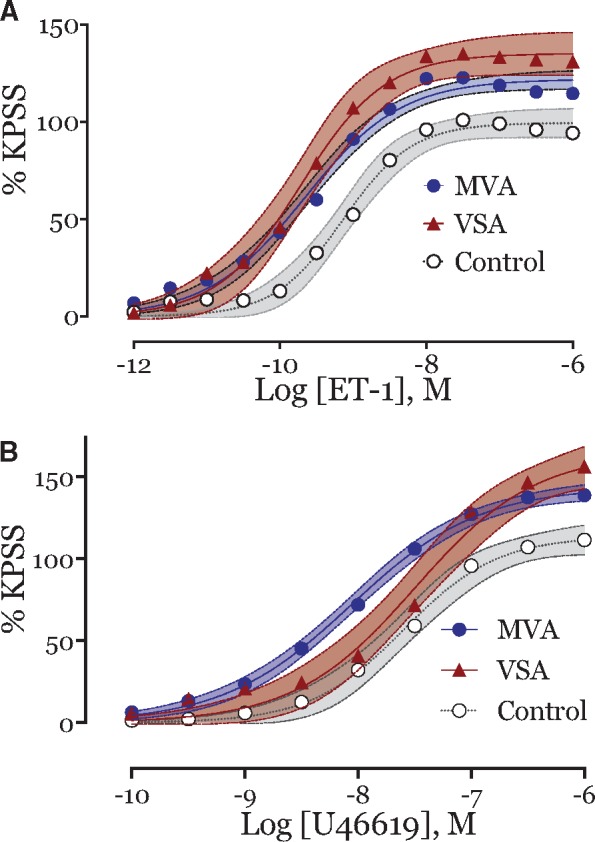
Cumulative concentration-response curves to constrictor agonists. (A) Increased maximum vasoconstriction to endothelin-1 in both microvascular angina subjects (blue circle, endothelin-1 Emax 121%, n = 54; P = 0.03) and vasospastic angina subjects (red triangle, endothelin-1 Emax 125%, n = 11; P = 0.02) vs. control subjects (○—white circle, endothelin-1 Emax 100%, n = 9; P = 0.02). No difference in endothelin-1 Emax between microvascular angina and vasospastic angina subjects (P = 0.397). Comparison of CCRC fit, P < 0.001. (B) Cumulative concentration-response curves to thromboxane analogue, U46619, in both microvascular angina subjects (blue circle, U46619 Emax 143%, n = 54; P = 0.01) and vasospastic angina subjects (red triangle, Emax 141%, n = 10; P = 0.04) vs. control subjects (○—white circle, endothelin-1 Emax 109%, n = 11). No difference in Emax between microvascular angina and vasospastic angina subjects (P = 0.932). Comparison of CCRC fit, P < 0.001. Each measure represents mean ± 95% confidence intervals for mean in shaded contours from CCRC best-fit.